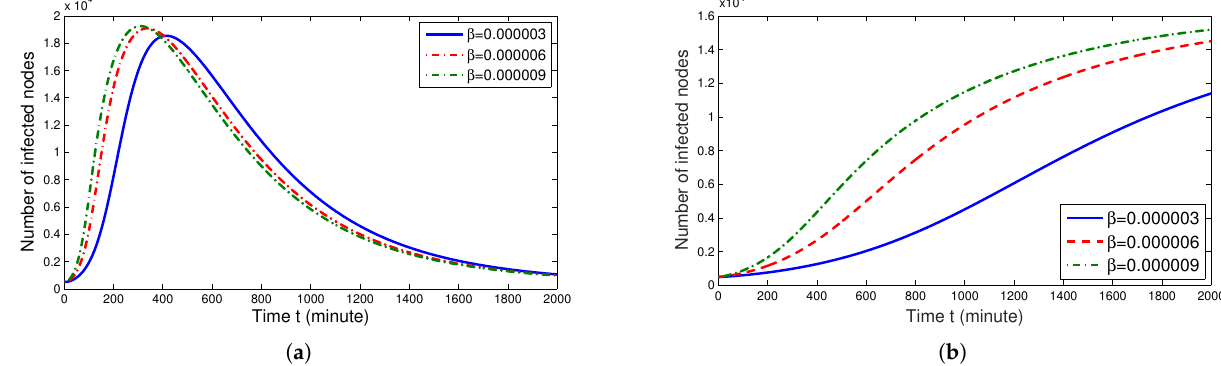
Figure 2. Effect of β on the infected nodes for the fractional order ( a ) θ = 0.95 and ( b ) θ = 0.65, respectively.